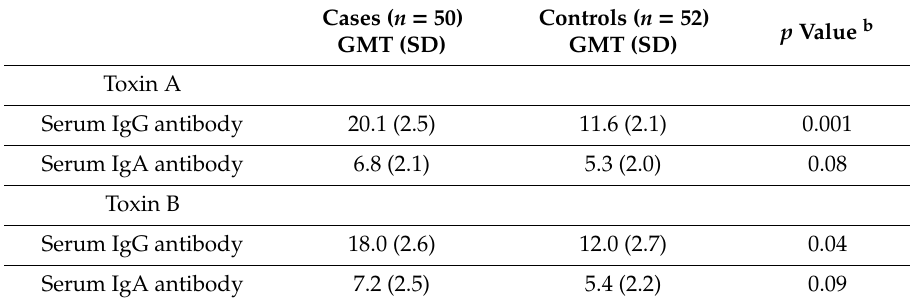
Table 1. Geometric mean titers (and standard deviations) of serum IgG and IgA antibody levels against toxin A and B of Clostridium di ffi cile among cases and controls a .